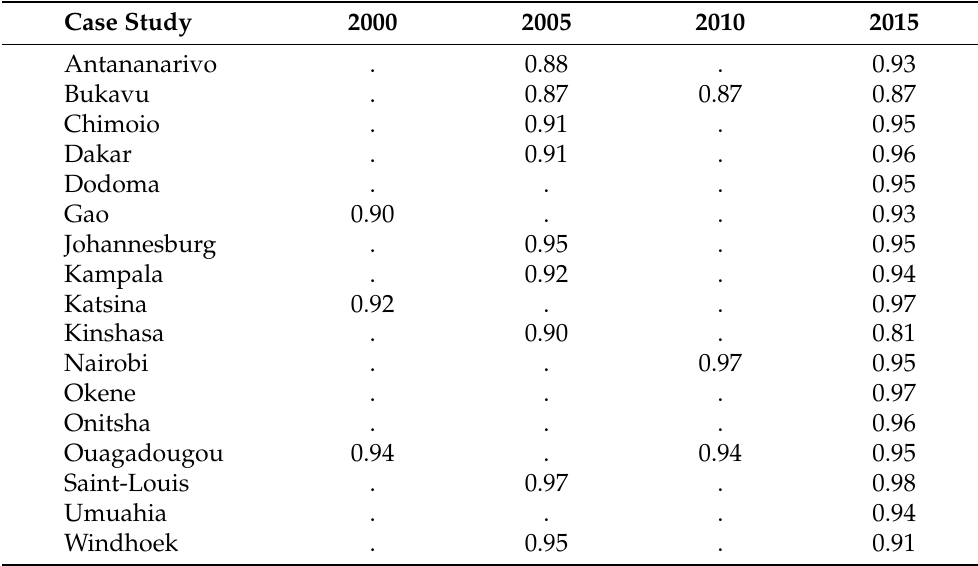
Table 3. F1-scores obtained by a sample of case studies based on an independent validation dataset. Case